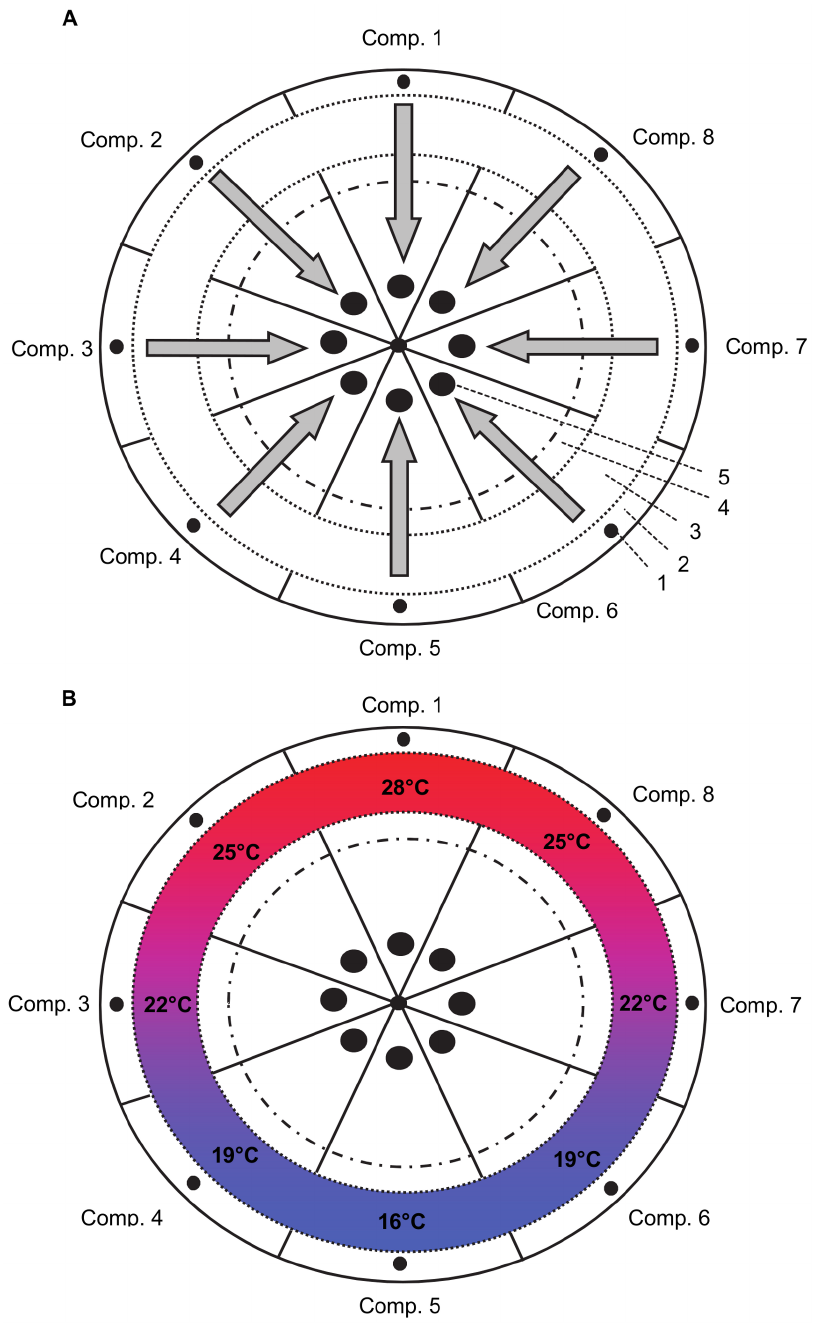
Figure 1. Schematic presentation of the preference chamber. Top view (A) presents schematically the water flows (arrows) and the main elements: 1) water inflow, 2) mixing channel, 3) swimming channel, 4) effluent channel, 5) central section with water drain. Top view (B) presents schematically the temperature gradient in the preference chamber.